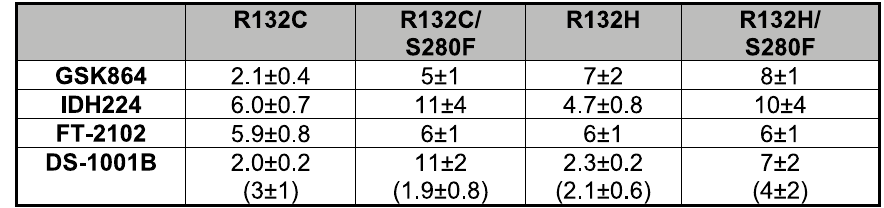
Fig. 3 | The S280F substitution causes changes in inhibitor potency varying with the active site substitution and type of inhibitor. a IC 50 values (standard errorofthemean, n =3)withIDH1variants(at30nM);n.i.=noinhibitionobserved. Conditions: 100mM Tris, 10mM MgCl 2 , 0.2mM DTT, 0.005% v/v Tween 20, and 0.1mg/mL BSA (pH 8.0). b Non-denaturing MS analyses. Dashed line: IDH1 dimer ( z =20, with 2 NADP(H) molecules bound), green shading corresponds to binding of one inhibitor molecule, mint shading corresponds to binding of 2 inhibitor